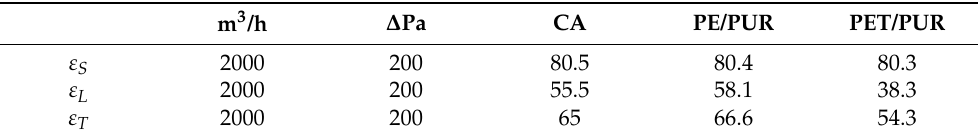
Table 6. Summarized effectiveness of the cores with a 20 µm membrane thickness under nominal conditions.